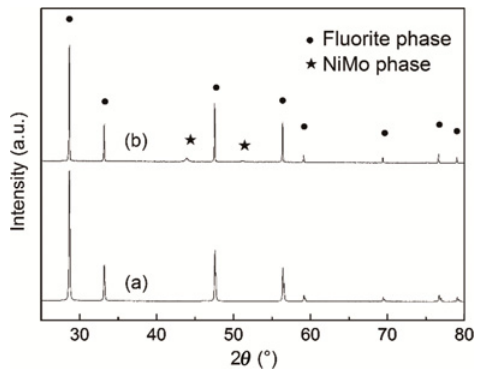
Fig. 2 XRD patterns of (a) porous Ce 0.9 Ca 0.1 O 2 − δ substrate and (b) NiMo–Ce 0.9 Ca 0.1 O 2 − δ catalyst